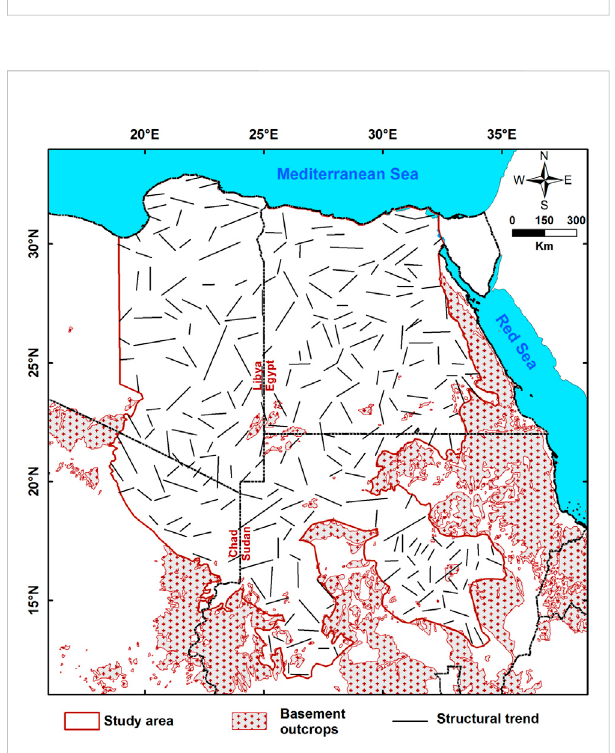
FIGURE 12 Gravity structural trends delineated from the residual gravity